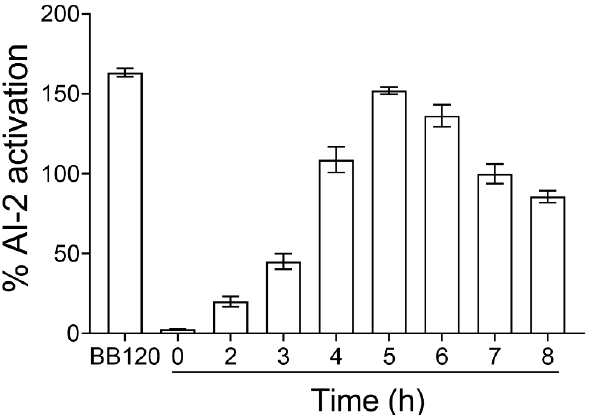
Figure 1. Time course of the AI-2 signaling activity in E. coli MG1655 . E. coli was grown in LB medium supplemented with 0.5% glucose at 37 ◦ C. At the indicated times, cell-free supernatants (CFSs) were prepared and assayed for AI-2 activity. The AI-2 signaling activity is presented as the percent activation compared to the non-inoculated negative control with CFS. A CFS obtained from an overnight culture of V. harveyi BB120 (AI-1 + , AI-2 + ) was used as a positive control.